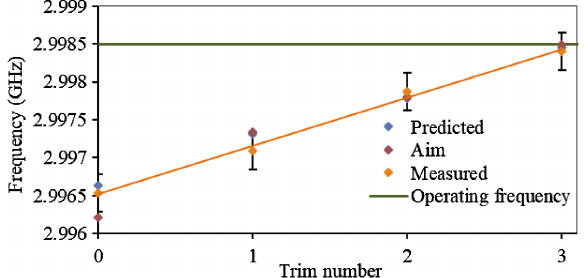
FIG. 17. Frequency of the 400 Hz photoinjector at each tuning step before brazing.